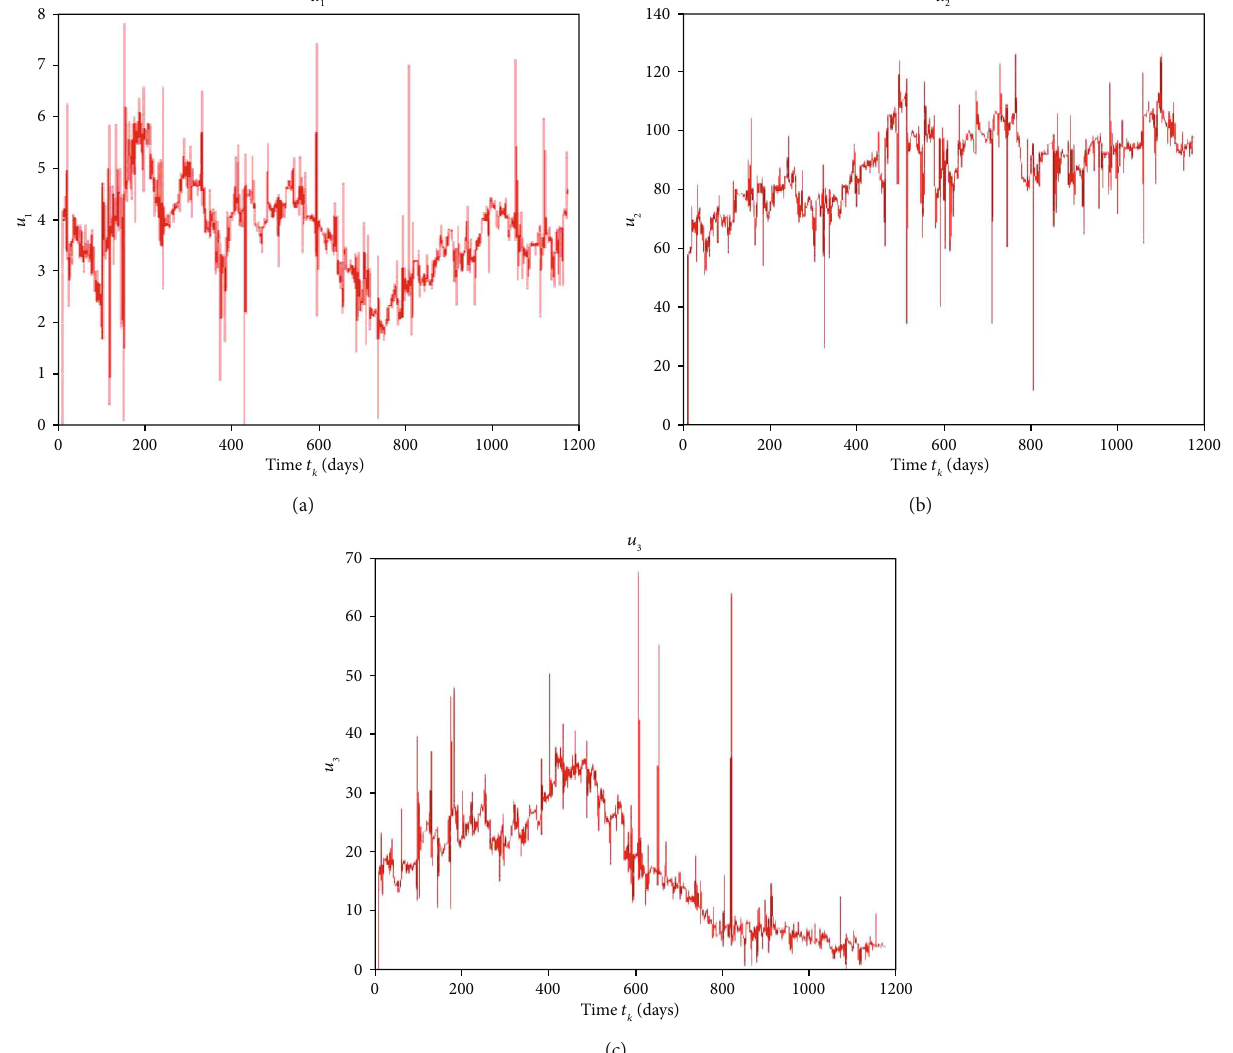
Figure 1: The graph of mean level u